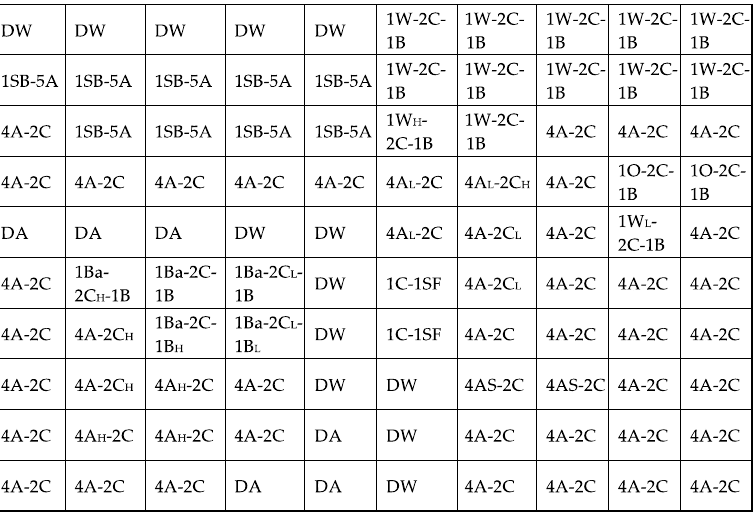
Figure 1. Land pattern of crop rotations.